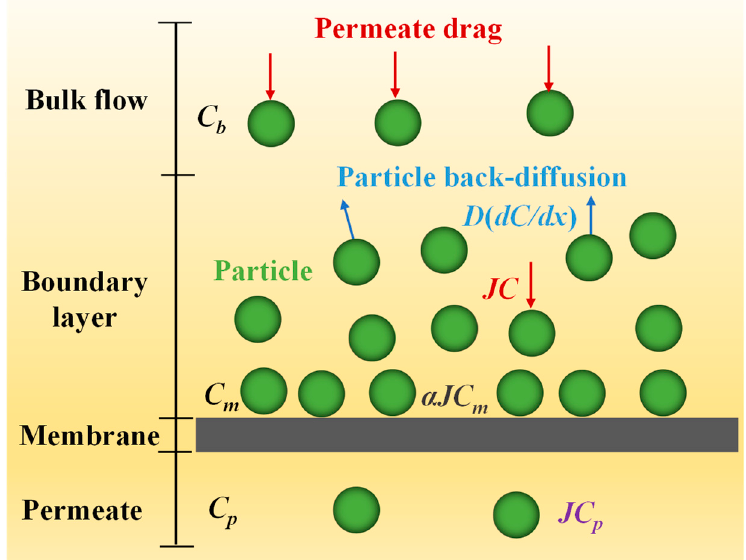
Figure 1. Schematics of fluid transport and CP during membrane filtration.